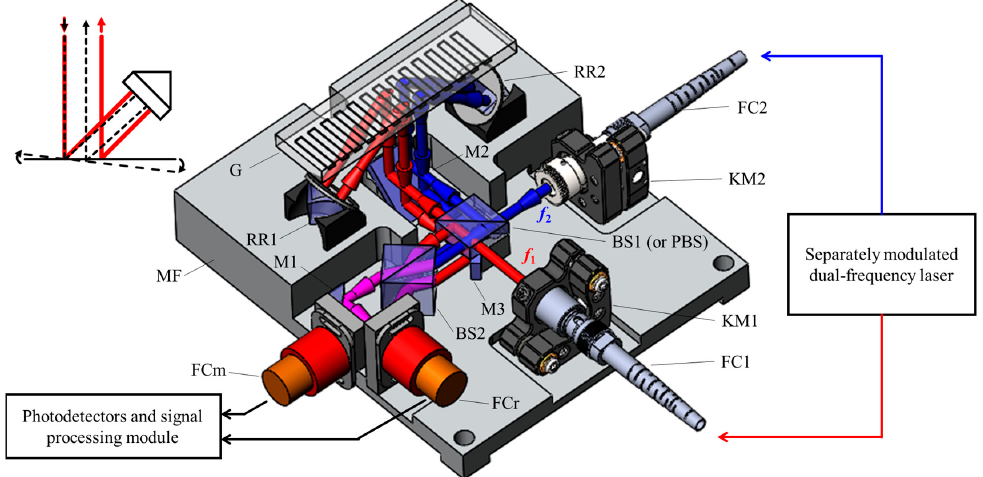
Figure 1. Optical configuration and mechanical fixture of the proposed double-diffracted spatially separated heterodyne grating interferometer. FC1 and FC2, optical fiber collimators; BS1 and BS2, non-polarized beam splitters; PBS, polarized beam splitter; M1, M2, and M3, mirrors; RR1 and RR2, retroreflectors; G, linear grating; FCr and FCm, optical fiber couplers; KM1 and KM2, kinematic mounts; MF, mechanical fixture. The colored markers f 1 and f 2 represent different modulated frequencies.